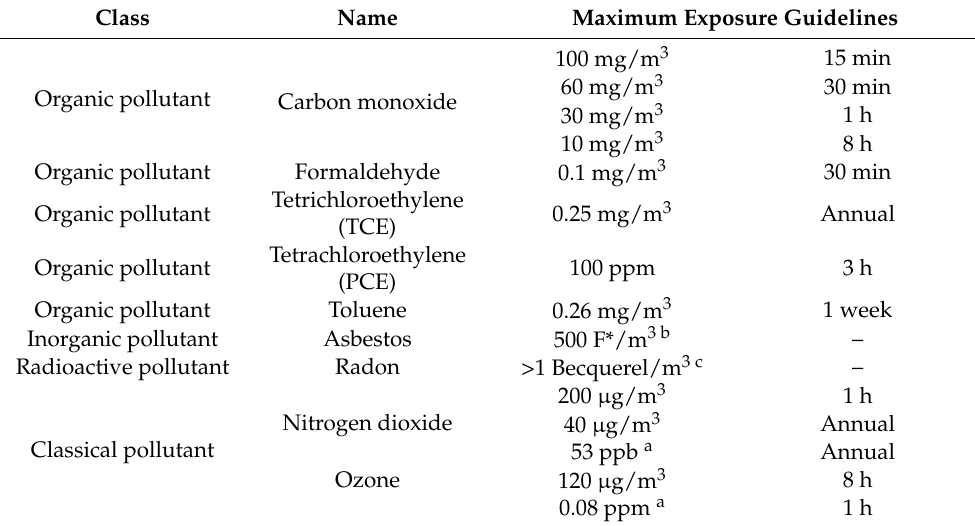
Table 2. Common indoor sources of volatile organic compounds adapted from the WHO